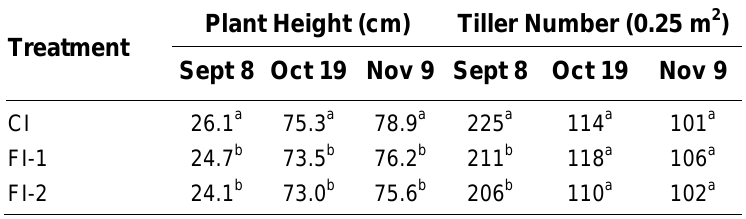
Plant Height and Tiller Numbers in the CI, FI-1, and FI-2 Treatments Conducted at Guandong Ocean University